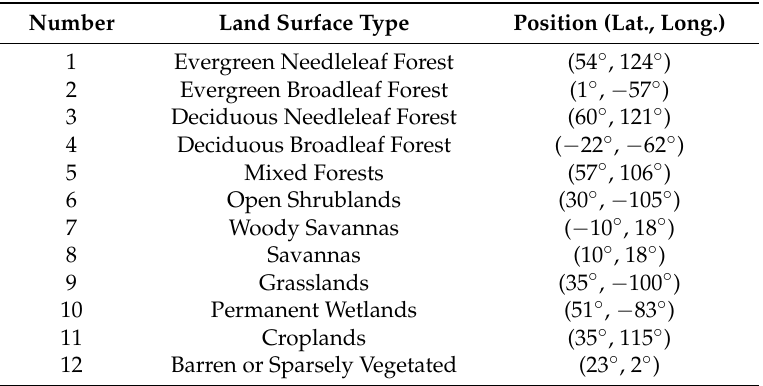
Figure 6. Distribution of selected validation points on global scale. Table 1. Land surface type and position of the selected validation